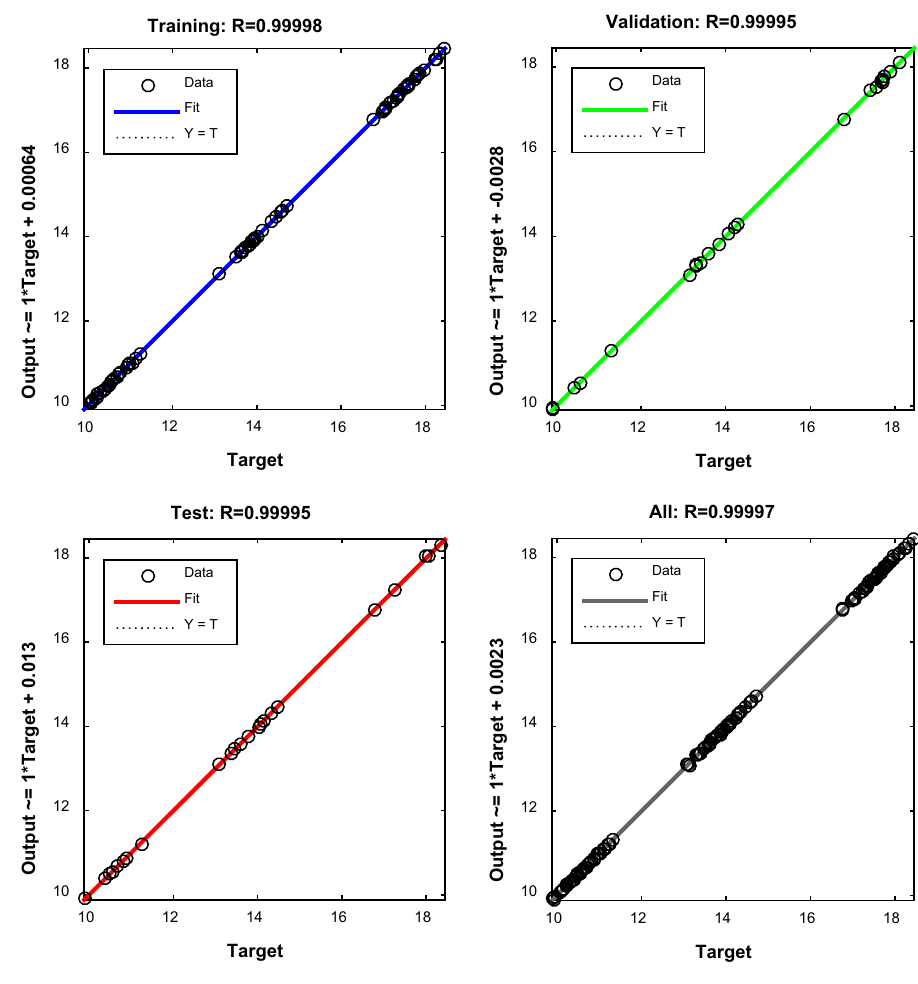
Fig. 2 Scatter plots of the devel- oped ANN